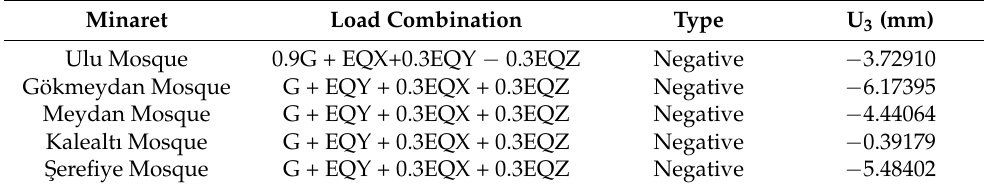
Table 11. Maximum displacements of Five Minarets in U Z